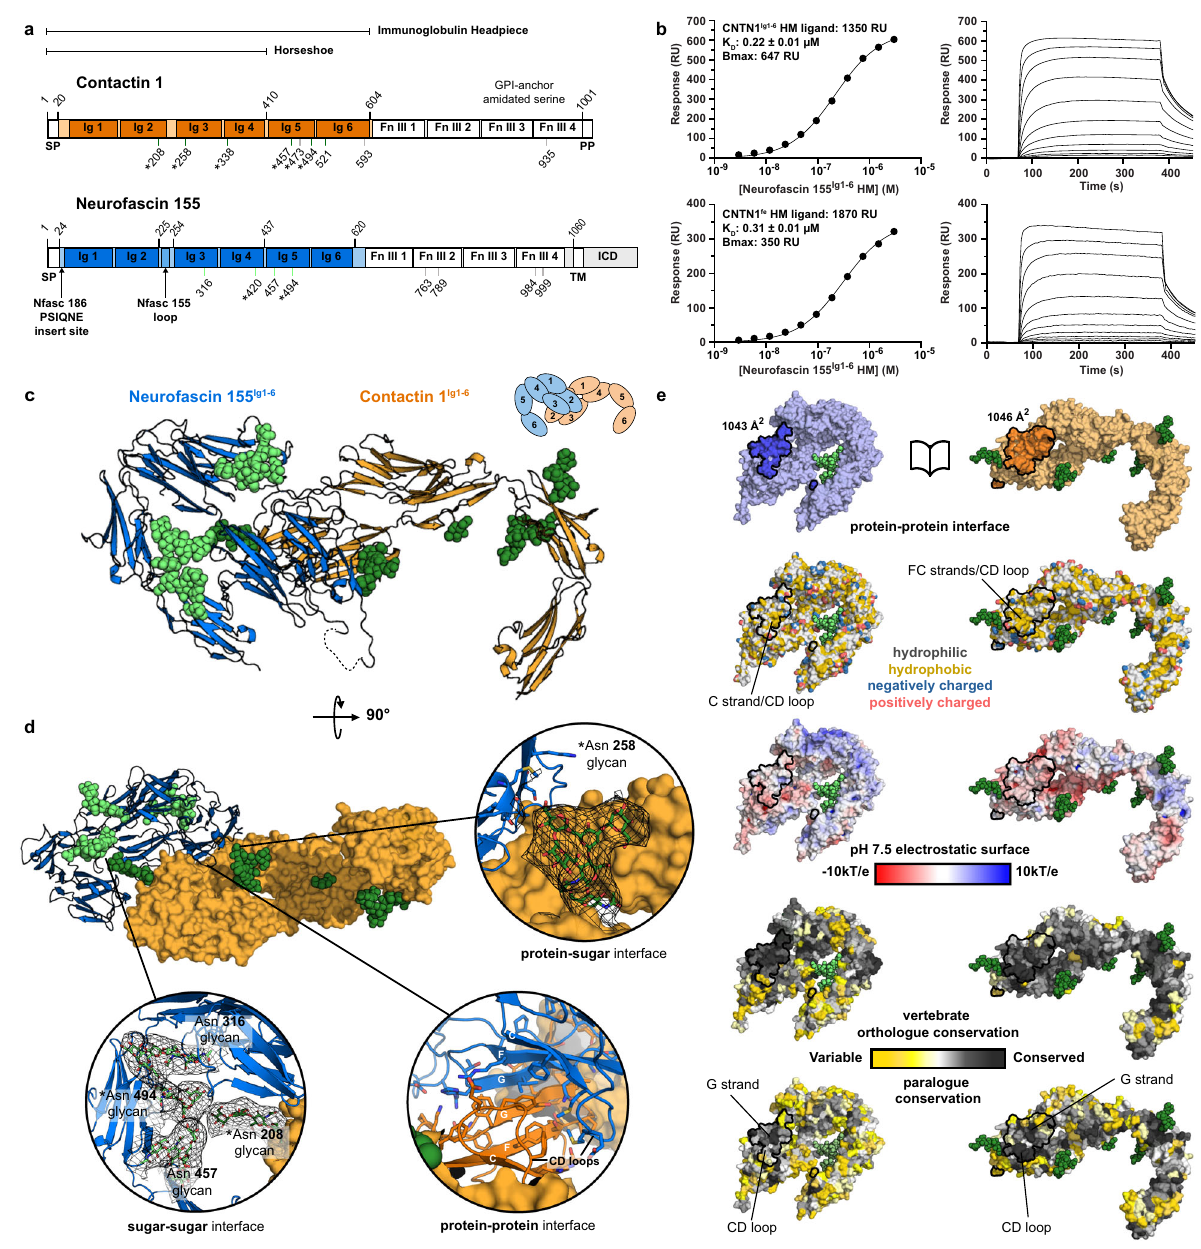
Fig. 1 | Structural and biophysical insights into contactin 1 – neurofascin 155 Ig1 – 2 mediated complex formation. a Annotated sequence schematic of con- tactin1andneurofascin155.Immunoglobulin-like(Ig)and fi bronectintypeIII(FnIII) domains are denoted with domain boundaries (top lines), and crystallized Ig seg- ments colored in. N-glycosylation sites (bottom lines) con fi rmed by structures (green),predicted(gray),andhighlyconservedinorthologueconservationanalysis (*). Signal peptide (SP), pro peptide (PP), transmembrane domain (TM), glyco- phosphatidylinositol(GPI)anchorandintracellulardomain(ICD)arealsoindicated. Neurofascin (Nfasc). b Surface plasmon resonance imaging interaction data of neurofascin 155 Ig1 – 6 containing high mannose glycans (HM) with contactin 1 Ig1 – 6 HM (top) or contactin 1 fe HM (bottom) ligands. Equilibrium binding data vs. analyte concentration modeled with a 1:1 Langmuir binding model shown left and asso- ciatedSPRsensorgramsshownright.Theaf fi nityofneurofascin155 Ig1 – 6 tocontactin